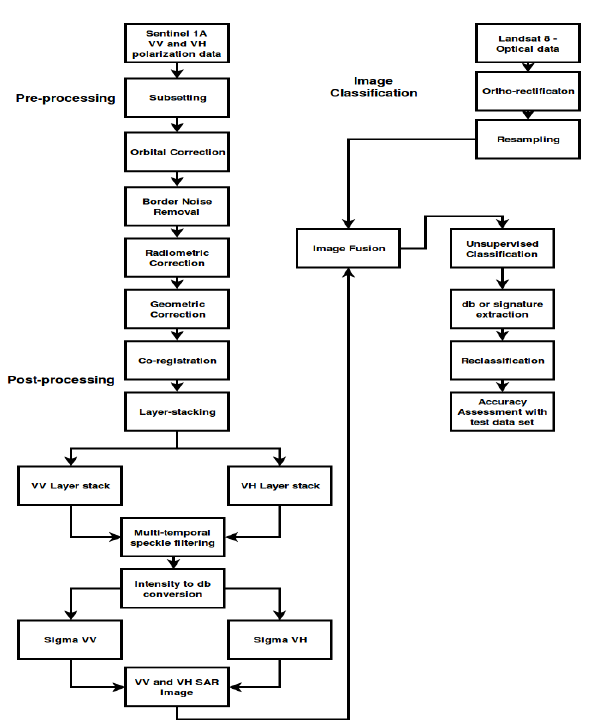
Figure 2. Methodology adopted